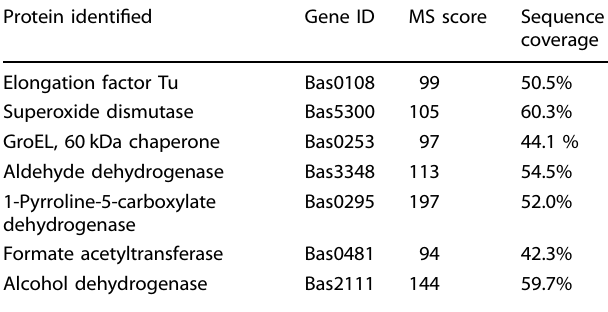
Table 2. List of proteins identi fi ed by immunoprecipitation with α - pSer/ α -pThr